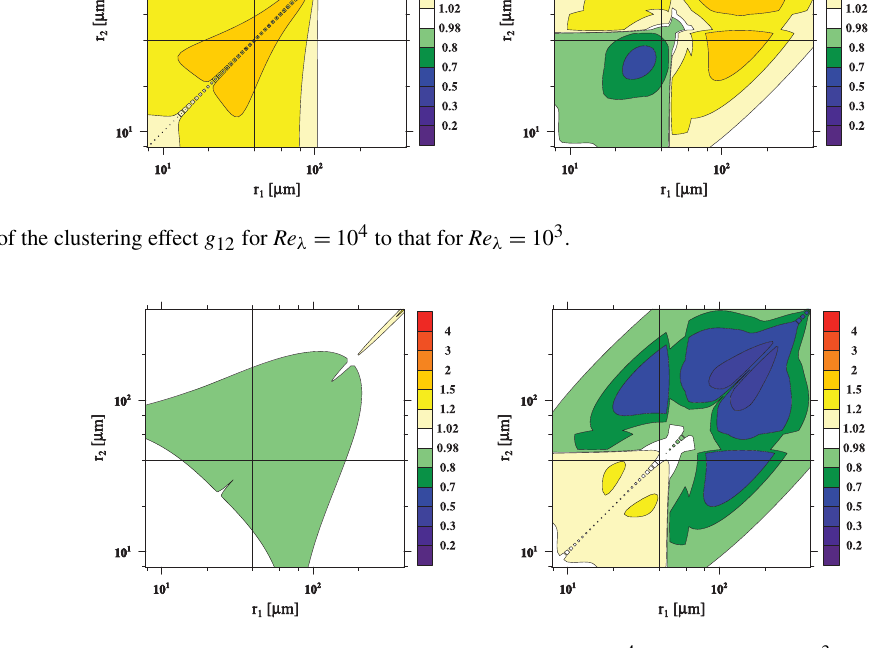
Figure 8. Ratio of the radial relative velocity at contact separation (cid:104)| w r |(cid:105) for Re λ = 10 4 to that for Re λ = 10 3